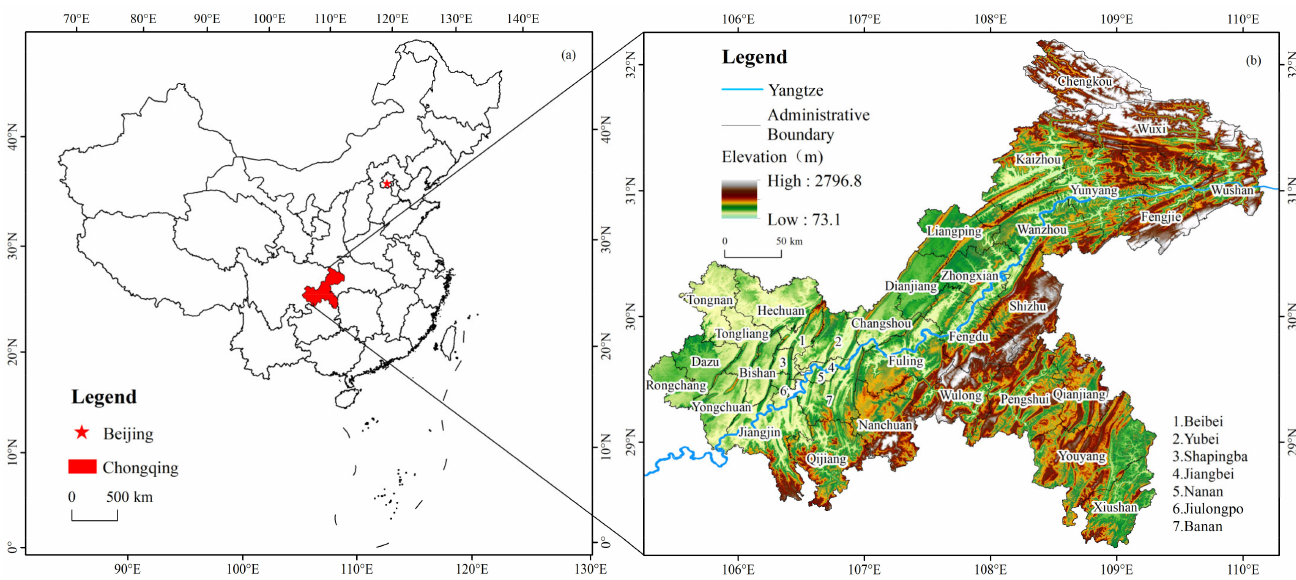
Figure 1. The study area: ( a ) the location of Chongqing in China; ( b ) the administrative divisions and elevation distribution of